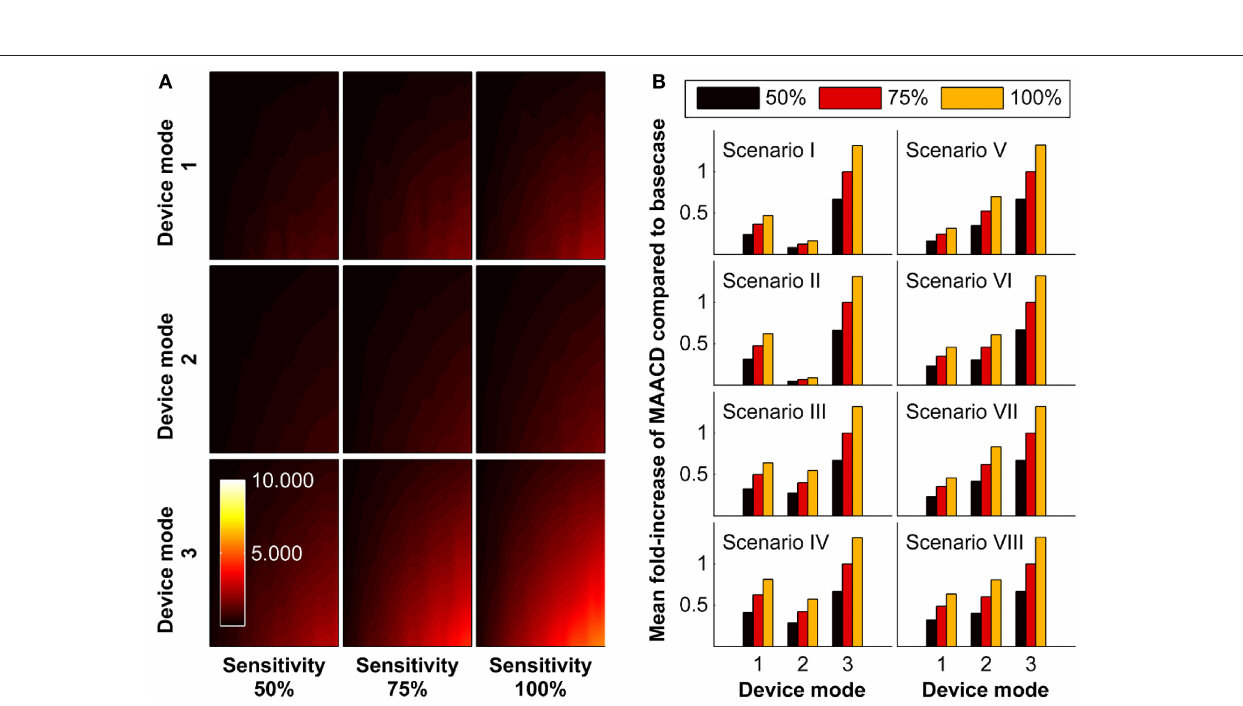
FIGURE 4 | Impact of mode of operation of the device and sensitivity of stroke detection on maximally allowable annual cost of device (MAACD) according to age and annual risk of ischaemic stroke. (A) MAACD according to age (vertical axes, 50–90 years) and annual risk of ischaemic stroke (horizontal axis, 1–20%) for different combinations of mode of operation of the device (M1, M2, M3) and sensitivity for stroke detection (50%, 75%, 100%) in the base-case socio-geographic scenario. (B) Mean fold-increase of MAACD associated with different combinations of mode of operation of the device (M1, M2, M3) and sensitivity for stroke detection (50%, 75%, 100%) compared to the base-case scenario (mode M3/sensitivity 75%) in socio-geographic scenarios I–VIII. MAACD ratios are not influenced by age or annual risk of ischaemic stroke (data not shown). For a definition of socio-geographic scenarios and modes of operation of the device, see main text and Tables 4 , 7 .